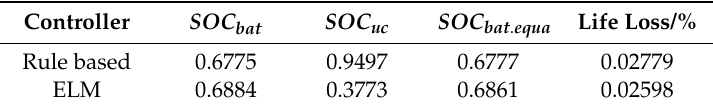
Figure 14. Life loss of the battery. Table 6. Simulation results of two control